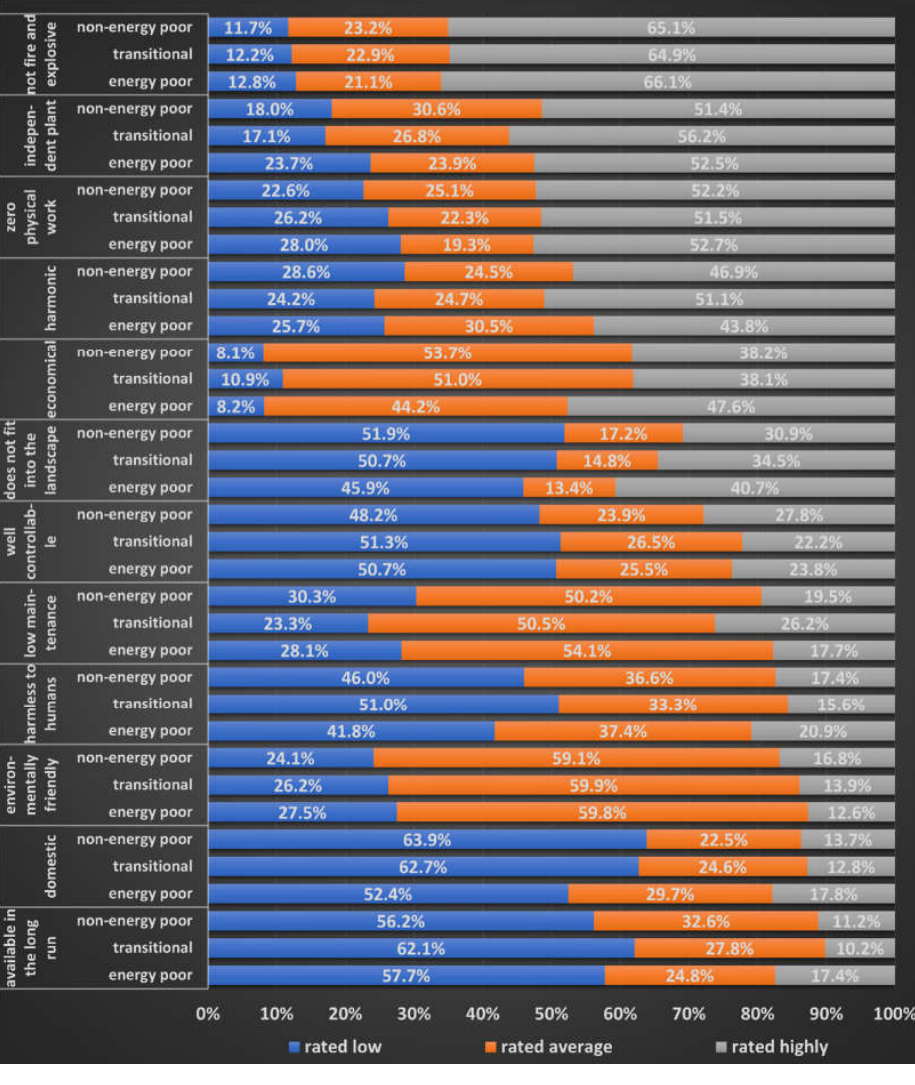
Figure A3. Aspects of the use of different heating methods by clusters. Not significant aspects. Compiled by the authors. Table A1. Chi-squares test statistics for the aspects of the use of different heating methods by energy vulnerability groups. Compiled by the authors.